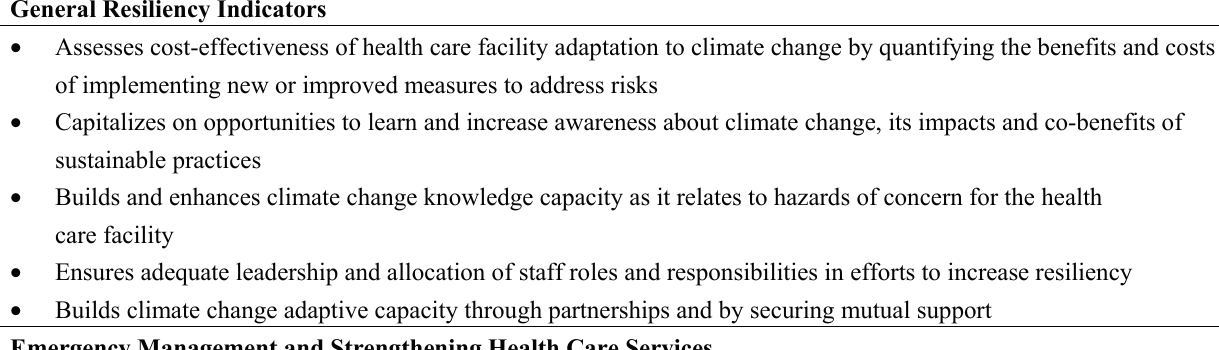
Table 1. Climate change resiliency indicators for health care